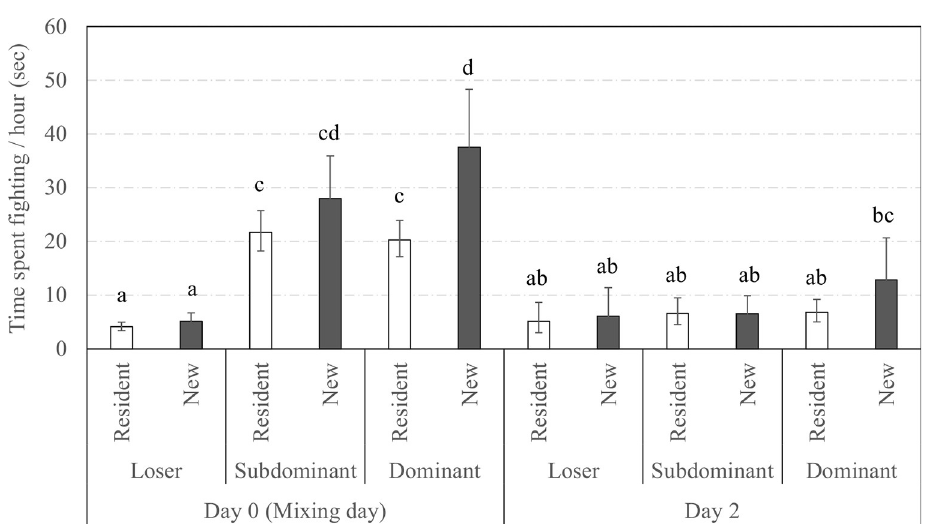
Fig 5. Time spent fighting across days according to social status and previous experience in the group. Back- transformed predicted mean [CI] time spent fighting (sec) per hour across observation days and according to the social status and the previous experience in the group. Different superscript letters indicate categories that significantly differ ( P < 0.050).